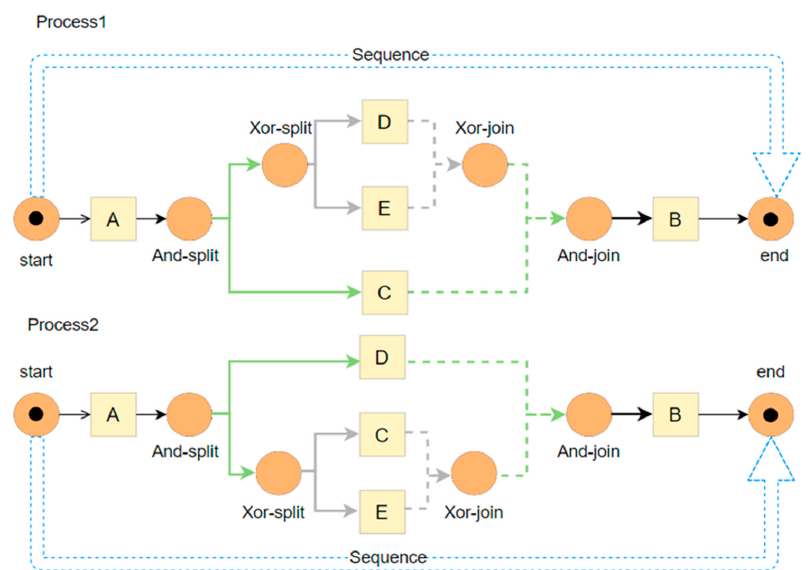
Figure 1. Business process models represented using Petri nets.